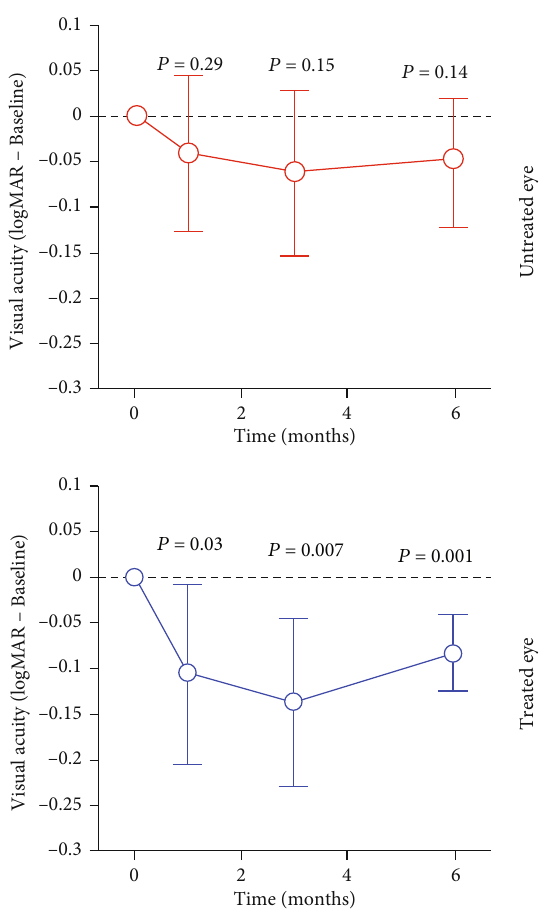
Figure 2: Graphical representation of the evolution of visual acuity in logMAR in relation to the follow-up time in months and the signi fi cance levels ( P ) of the treated eye × untreated eye.